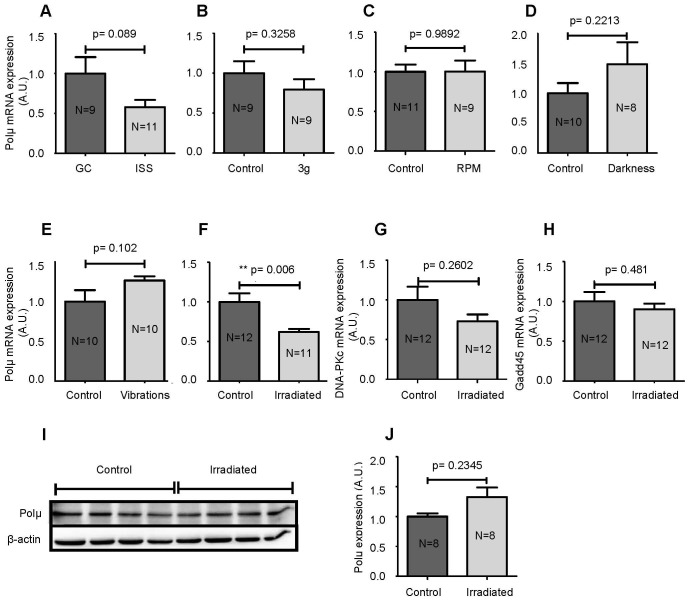
Effects of spaceflight conditions.Polµ mRNAs were quantified in larvae that developed in microgravity in the ISS (A), in hypergravity (B), in the RPM to simulate microgravity (C) or in the dark (D). The same study was performed with larvae subjected to a mechanical stress (E) or the ISS radiation environment (F). The effects of space radiation on DNA-PKc (G) and Gadd45 (H) mRNAs and on the amount of Polµ protein (I and J) were also investigated. Western blot results were analyzed and quantified by densitometry using a Fusion Fx7 imaging system (Vilber Lourmat, Marne-la-Vallée, France) and Polµ expression was normalized to β-actin (J). Each lane of the western blot contains proteins from 3 larvae. Results are expressed as the mean ± SEM. “A.U.” stands for “arbitrary units”.